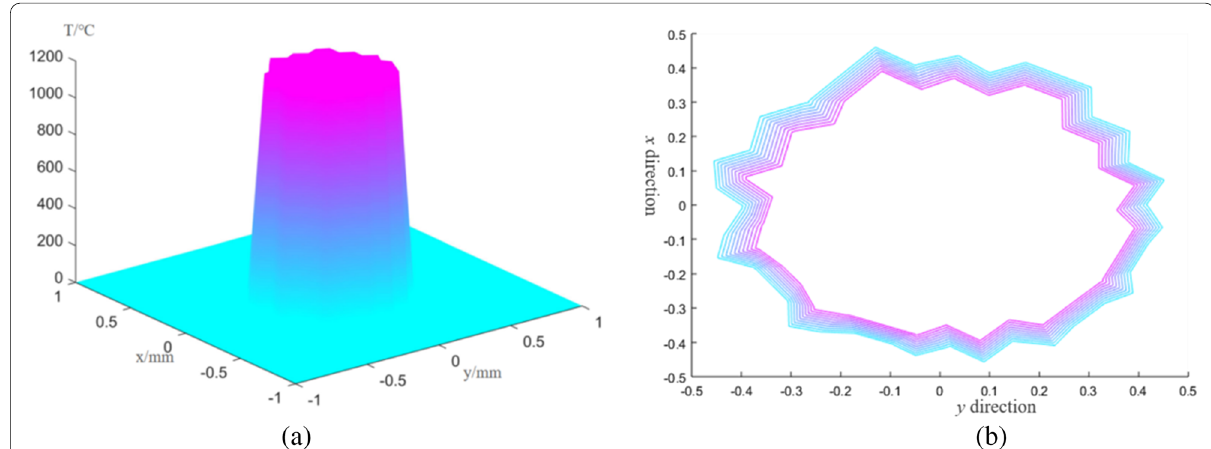
Fig. 5 . a Wood surface temperature distribution. b Wood surface isotherm